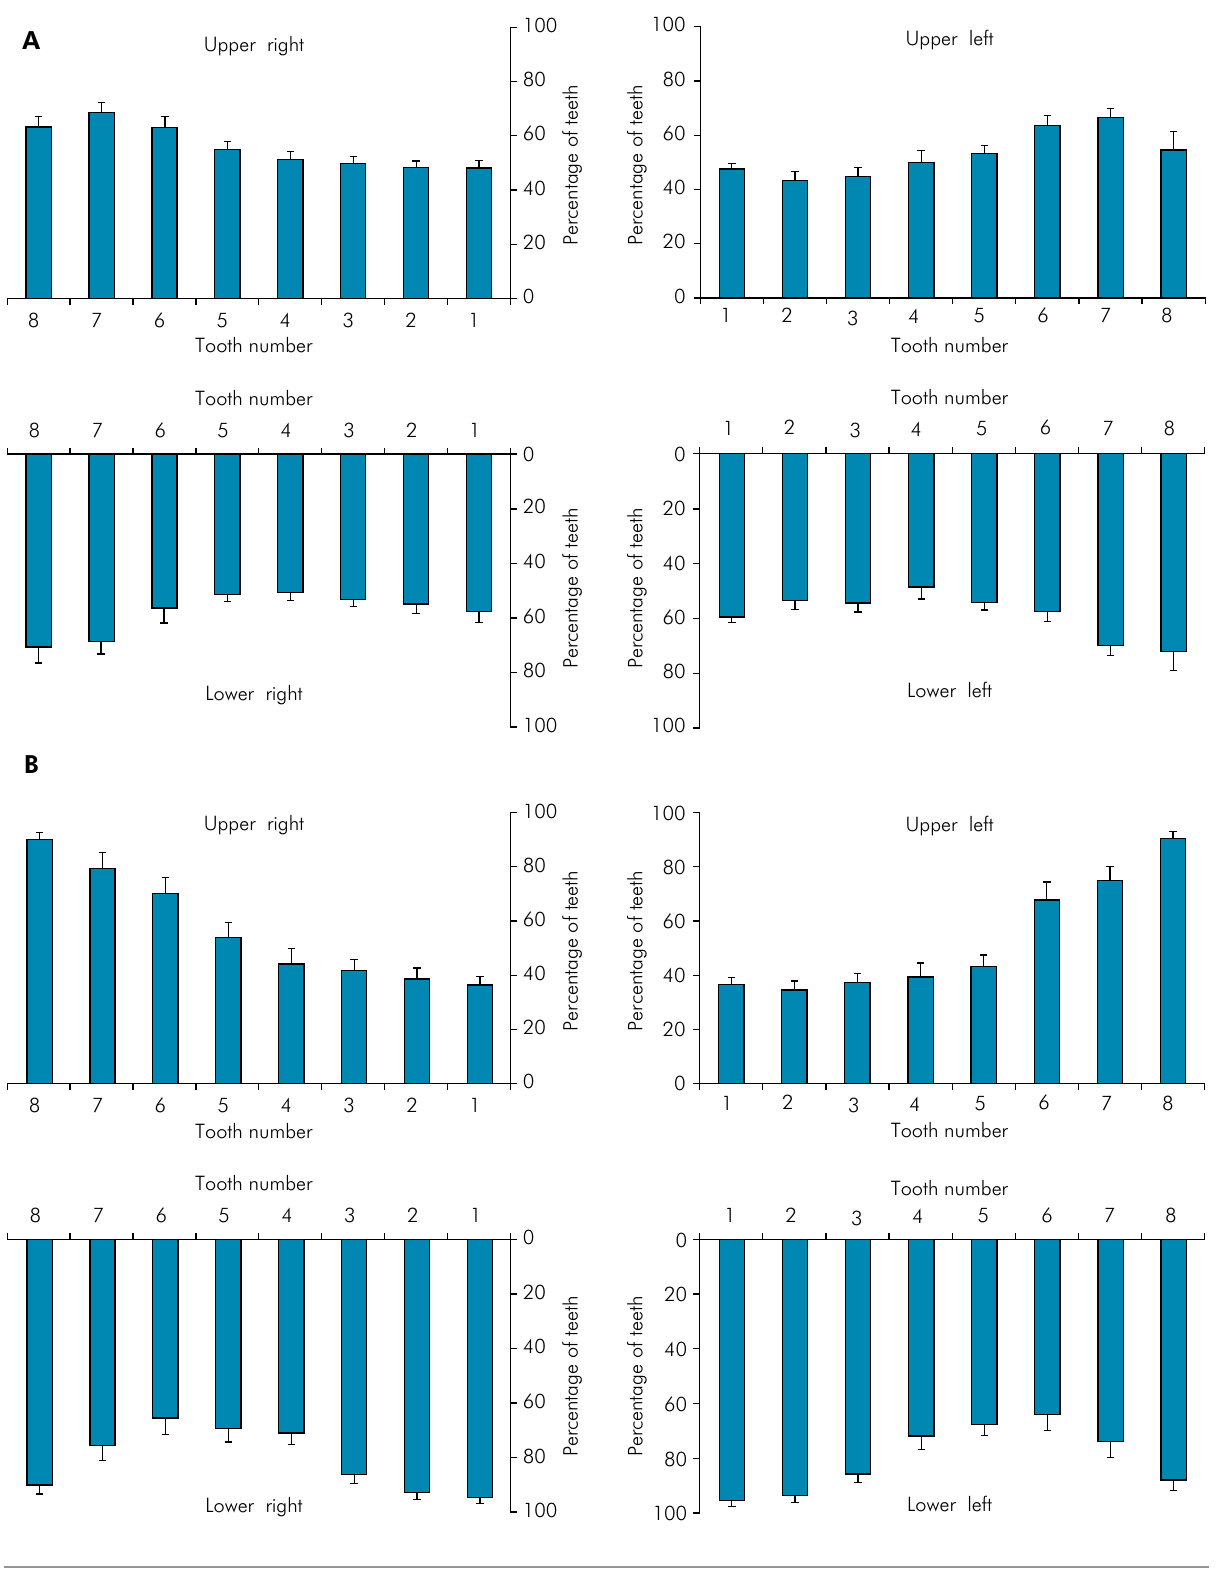
Figure 2. Intra-oral distribution of gingivitis (a) and calculus (b): percentage of teeth with at least one site with gingival bleeding or calculus according to tooth type and arch (central incisor:1, third